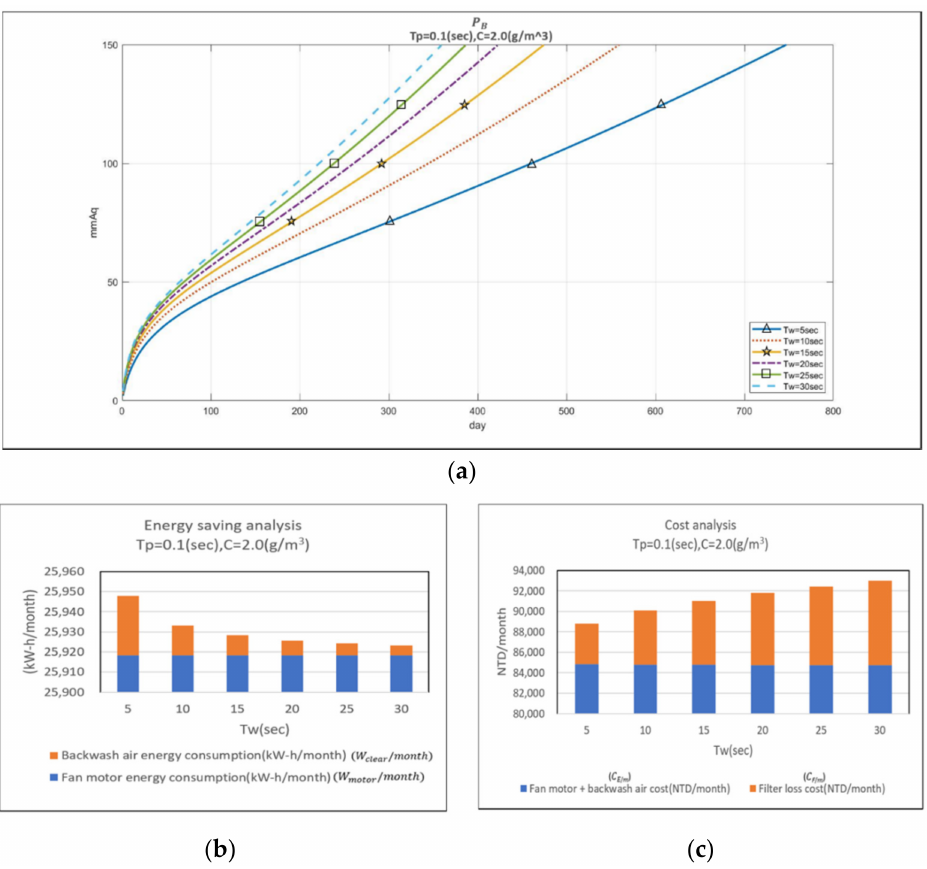
Figure 8. The simulation of energy consumption on different pulse interval times. ( a ). The analysis of the pressure drop. ( b ). The analysis of energy saving. ( c ). The analysis of